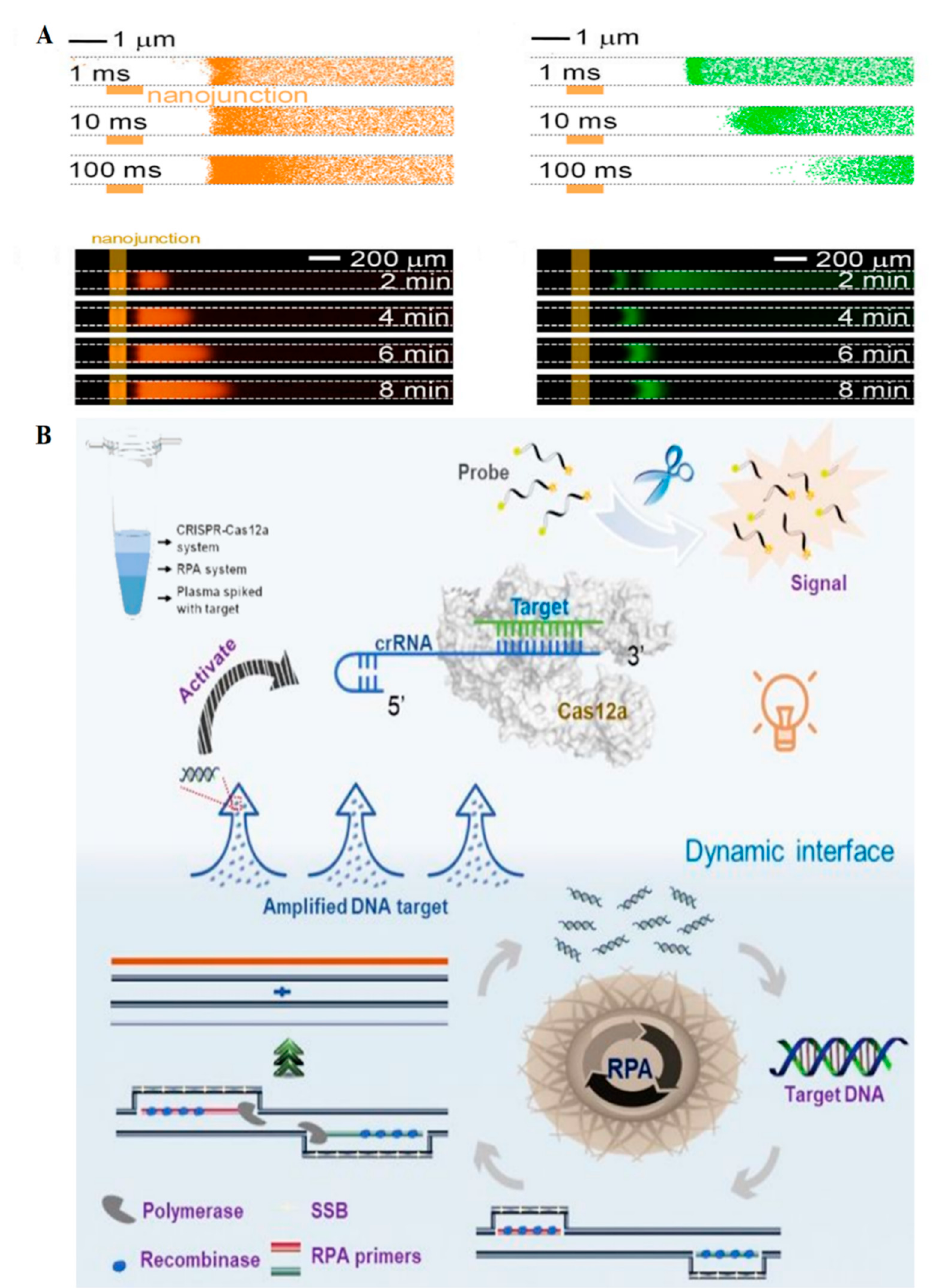
Figure 3. ( A ) The microfluidic platform with a microchannel creating ion concentration polarization (ICP) shows two different mobility behaviors of bound and unbound DNA-CRISPR complexes. Green and orange colors represent the stacking and propagation mobility behaviors, respectively [30]. ( B ) The DAMR platform represents the dynamic diffusion of cleaved nucleic acid products after Cas12 trans cleavage activity through the multiphase sucrose solutions with different concentrations